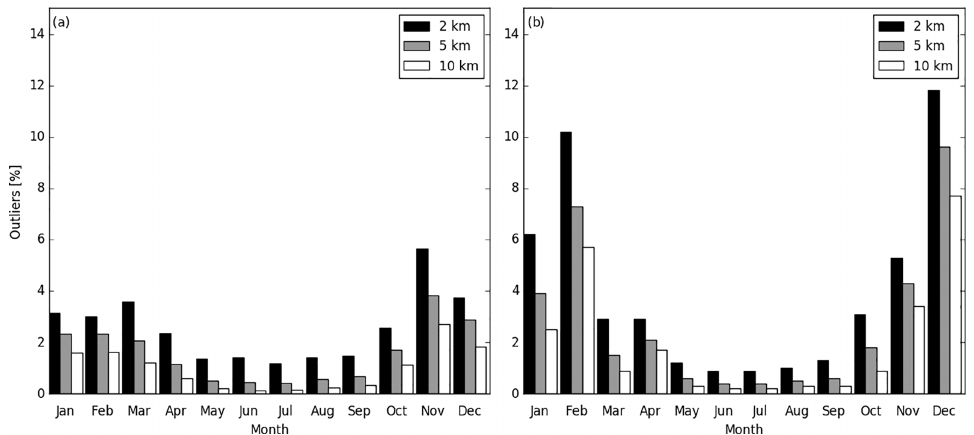
Figure 6. Monthly distribution of the total (CG + IC) percentage of outliers in (a) Belgium and (b) Austria for search radii of 2, 5 and 10km.